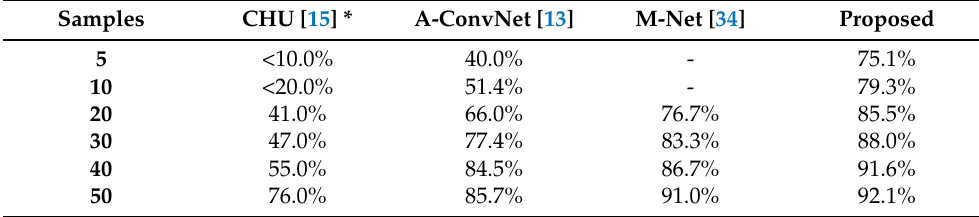
Table 3. Classification accuracy of different methods based on different number of training samples.